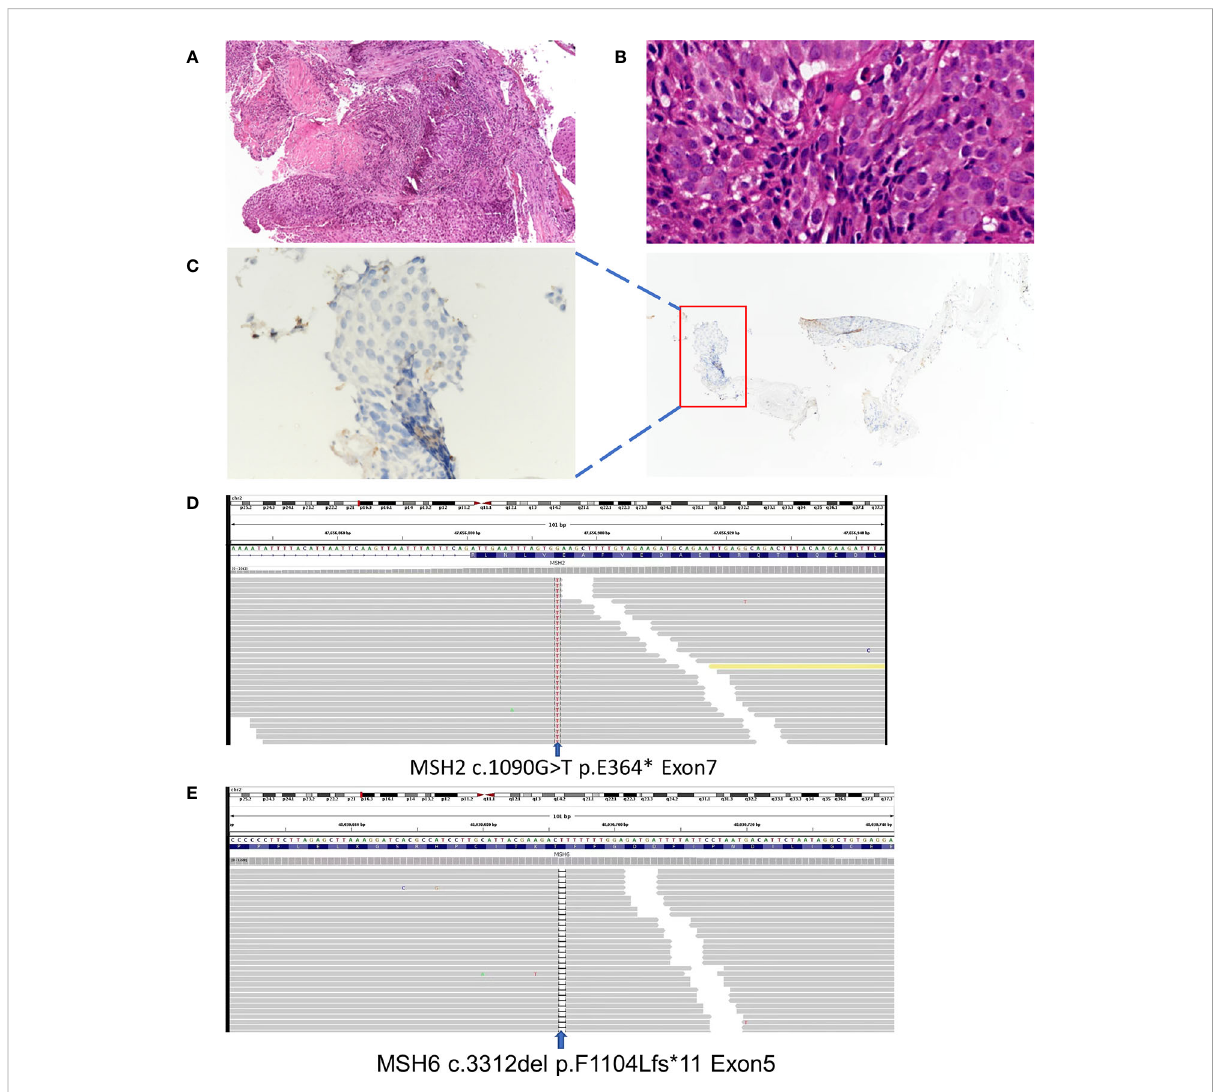
FIGURE 2 Basic information: (A) Lung tumor tissue stained with hematoxylin and HE, (magni fi cation, ×100) (B) Lung tumor tissue stained with hematoxylin and HE, (magni fi cation, ×400) (C) PD-L1 immunohistochemical (IHC) pathology, (magni fi cation, ×400). (D) Next-generation gene sequencing revealed mutations in theMSH-2. (E) Next-generation gene sequencing revealed mutation in the